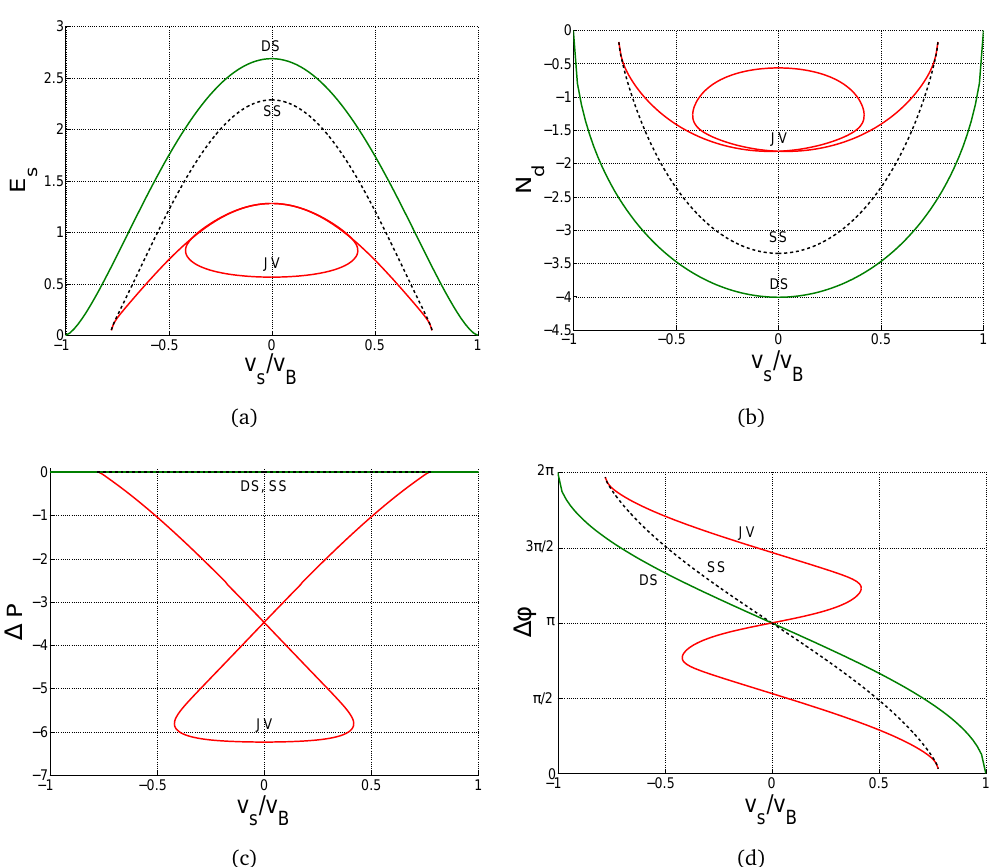
Figure 8: Intermediate cross-interaction, weak coupling regime ( γ = 0.5, ν = 0.005). Energy (a), missing particle number (b), angular momentum (c) and phase difference (d) as a function of velocity. Properties of Josephson vortices (labeled ‘JV’) are plotted in red, those of dark solitons (labeled ‘DS’) in green, and quantities associated with staggered solitons (labeled ‘SS’), in black. Solid lines indicate stable solutions, while dashed lines depict unstable ones.